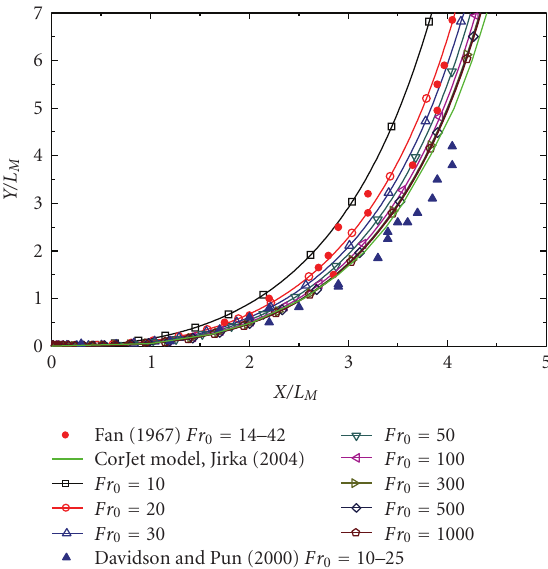
Figure 4: Normalized trajectories of horizontal buoyant jet.